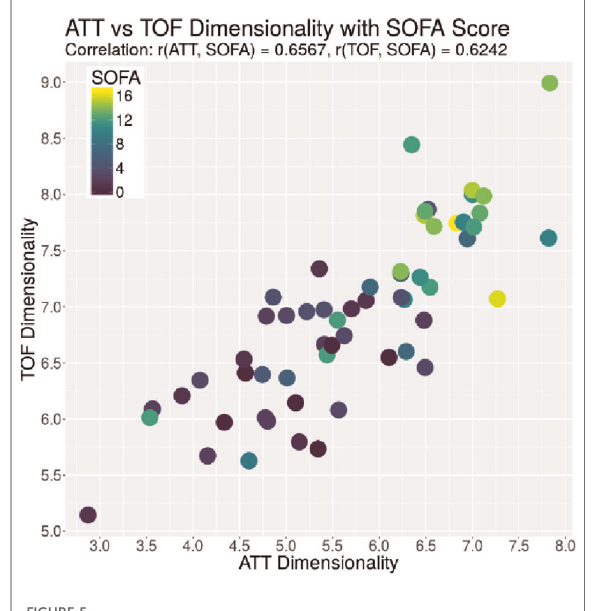
FIGURE 5 Plot of the dimensionality of the ATT vs. the dimensionality of the TOF. Every dot represents one patient on day 1; the color represents the SOFA score of that patient on that day.